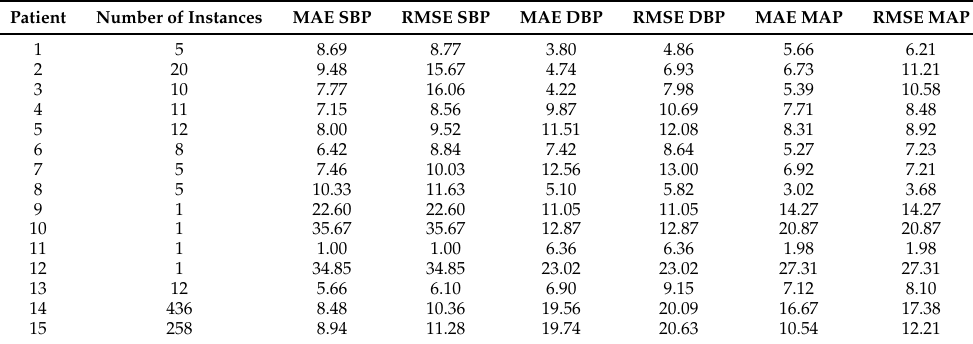
Table 6. MAE and RMSE evaluation for SBP, DBP and MAP.